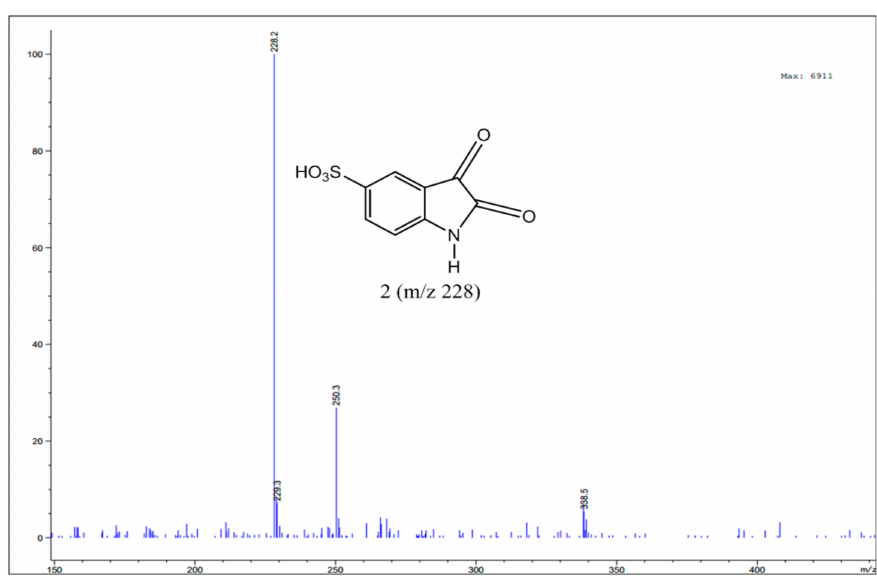
Figure 9. LC-MS analysis of indigo carmine solution adsorbed by virgin resin sample.